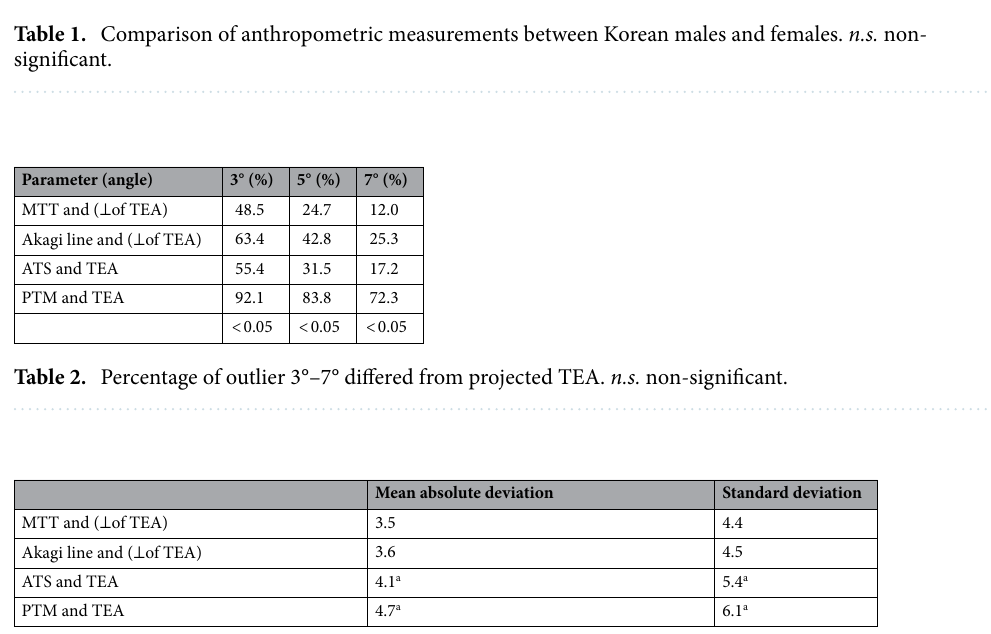
Table 3. Mean absolute deviation and standard deviation from projected TEA. n.s. non-significant. a Significant different from MTT.